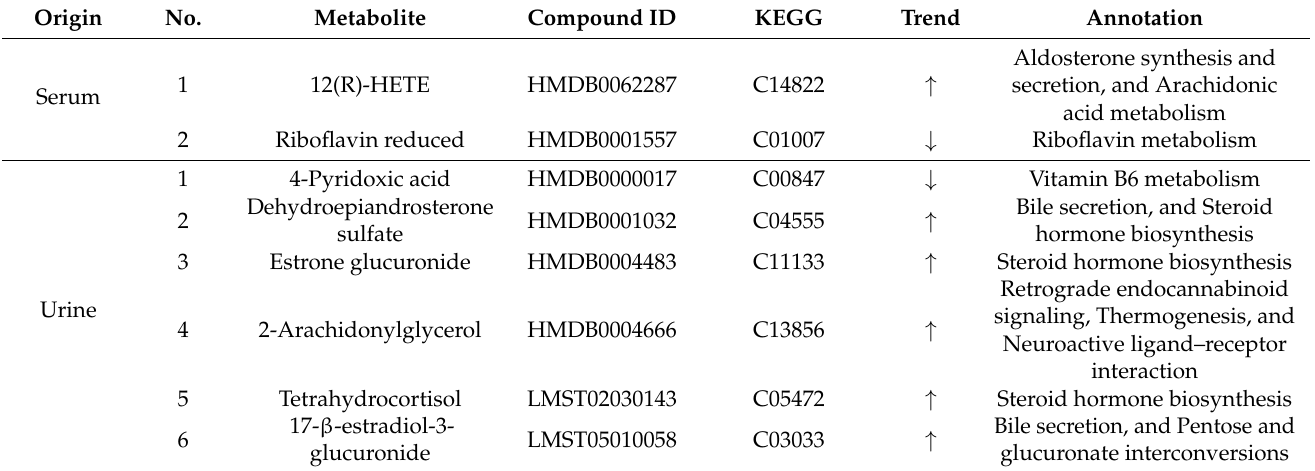
Table 3. Enriched KEGG pathway of metabolites from Ginsenoside Re vs. T2DM